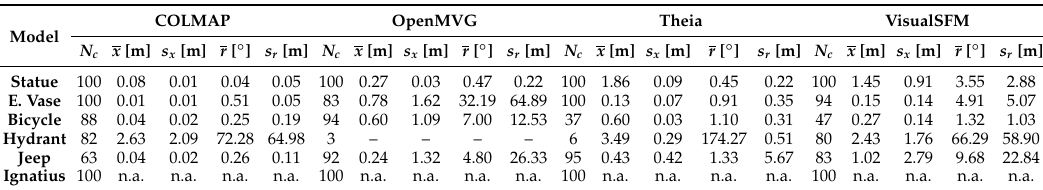
Table 3. SfM camera pose evaluation results. N c is the percentage of used cameras. x is the mean distance from ground truth of reconstructed camera positions and s x its standard deviation. r is the mean rotation difference from ground truth of reconstructed camera orientations and s r its standard deviation. n.a. means measure not available.